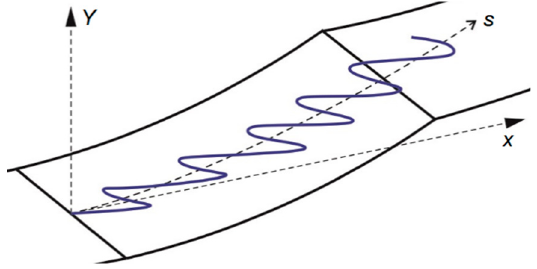
Figure 7. Kinematics of cutting grains in the contact zone.